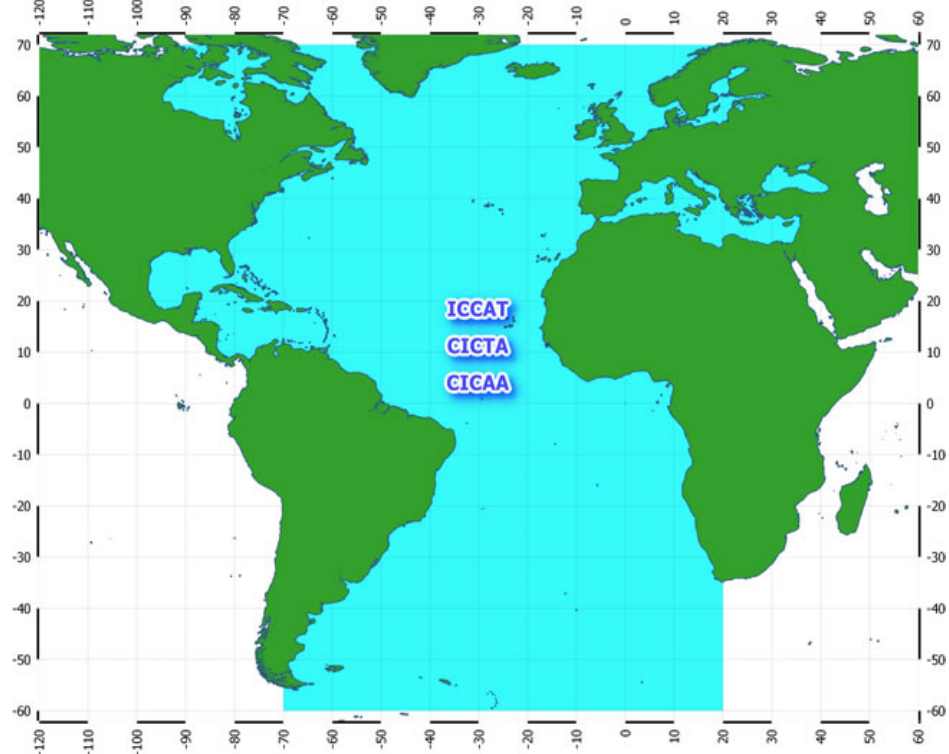
Figure 2. Convention Area of the ICCAT. Reproduced from [24], with permission from International Commission for the Conservation of Atlantic Tunas, 2022.